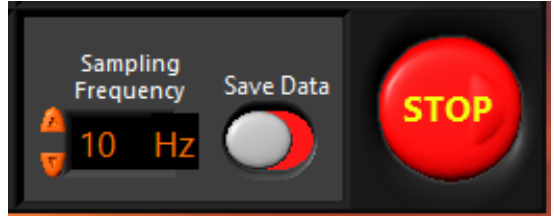
Figure 19. Save data, sampling frequency, and stop controls.